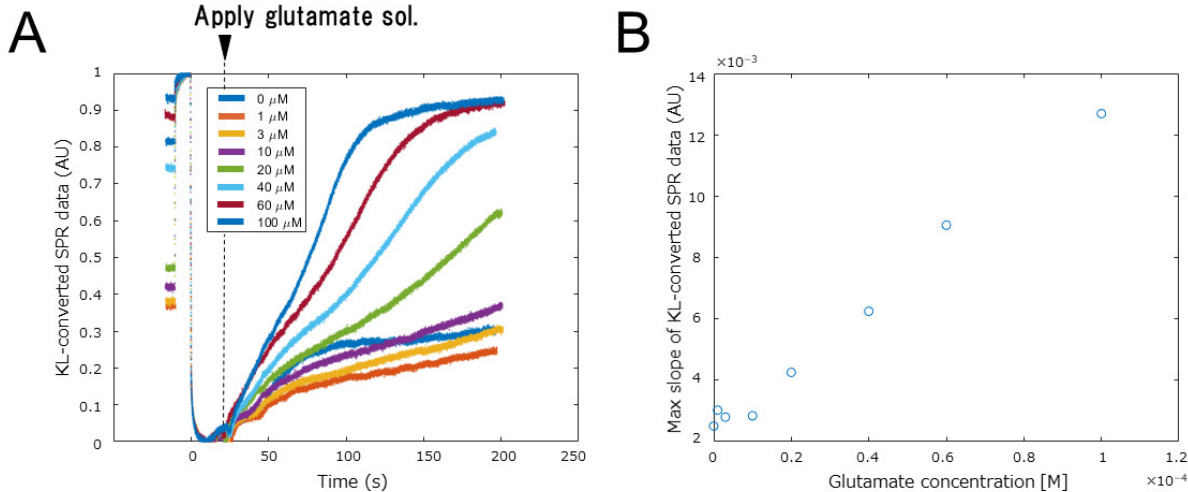
Figure 9. Variation in KL-converted SPR data with glutamate concentration. ( A ) Raw KL-converted SPR data versus glutamate concentration. ( B ) Calibration curve for glutamate detection using the maximum slope of KL-converted SPR data.